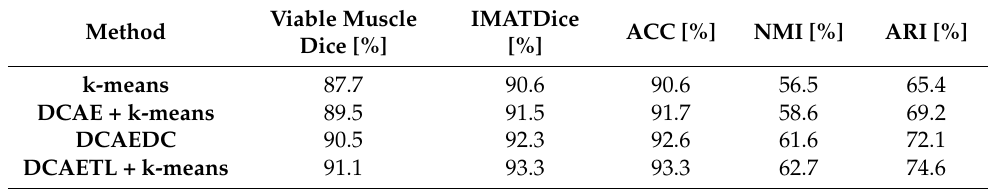
Table 2. Evaluation of the suggested FCN classification into viable muscle and IMAT in comparison to other common clustering approaches. As can be seen, our DCAETL + k-means approach produced the most accurate segmentation results—both in identifying viable muscle and IMAT. ACC was calculated based on Equation (10). See Section 2.6.3 for more detailed information on each evaluation metric.